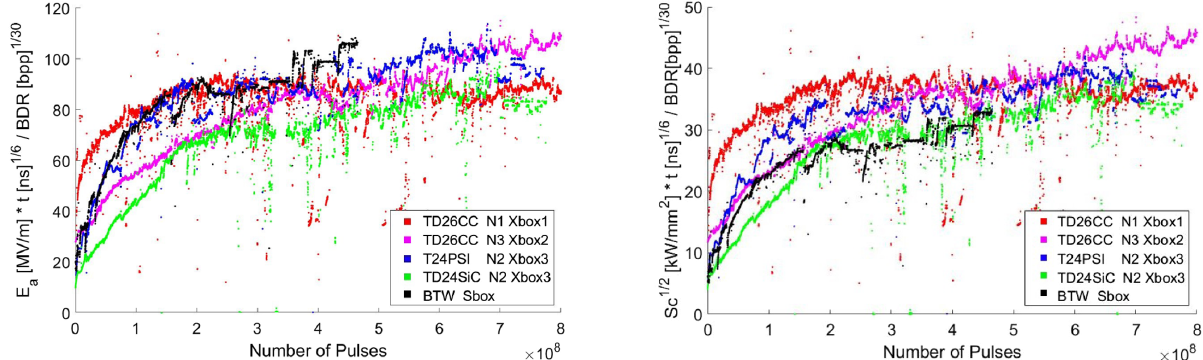
FIG. 20. Comparison of the scaled accelerating gradient (left) of the first cell and the scaled peak modified Poynting vector S with respect to the number of pulses for: TD26CC N1 (Xbox-1), TD26CC N3 (Xbox-2), T24PSI N2 (Xbox-3), T24SiC N2 (Xbox-3), and BTW N1